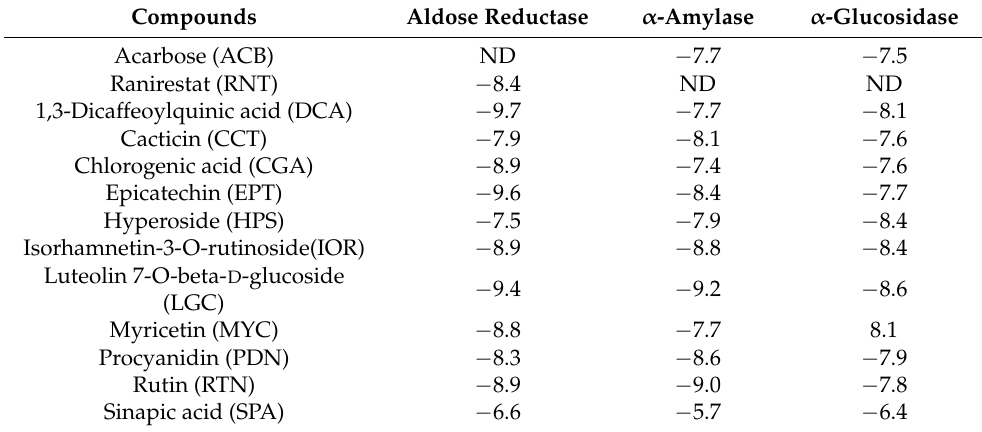
Table 3. Molecular docking scores (kcal/mol) of the phenolic compounds with carbohydrate hy- drolyzing enzymes and aldose